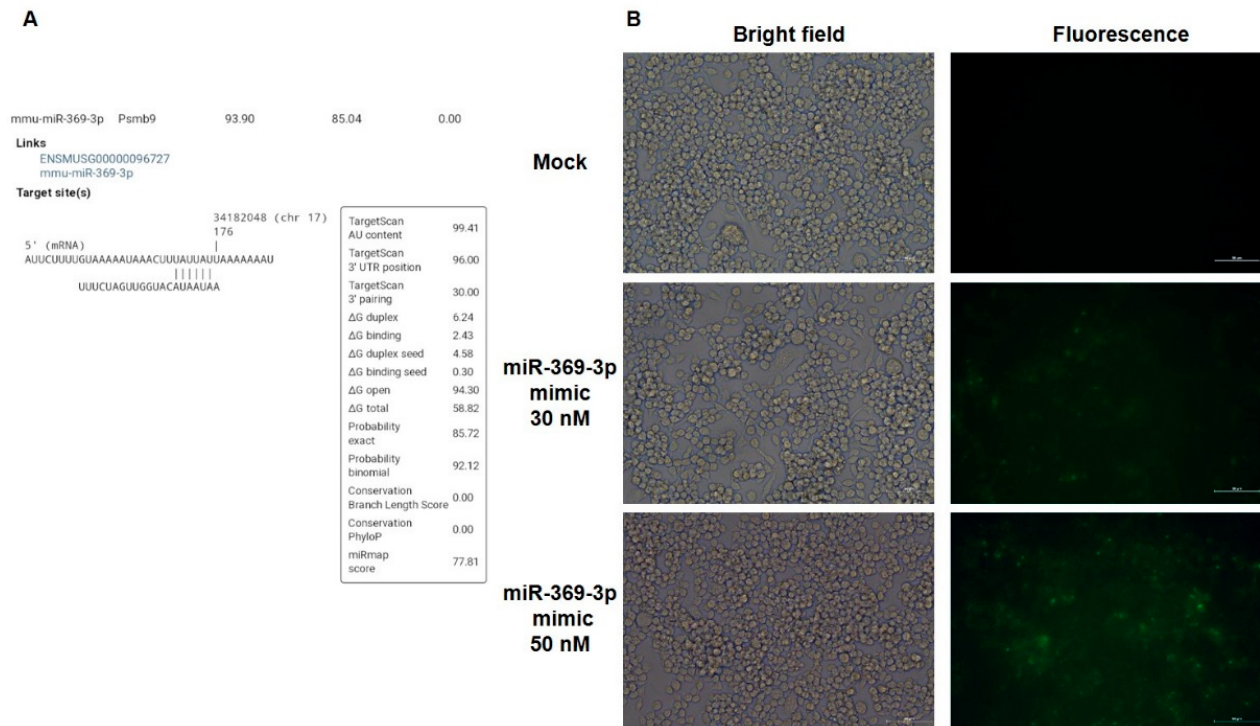
Figure 1. miR-369-3p targets Psmb9, binding a specific sequence in 3 ′ UTR mRNA. ( A ) Sequence alignment of the miR-369-3p base pairing sites in 3 ′ UTR of Psmb9 mRNA. ( B ) Transfection efficiency of RAW 264.7 mouse macrophages. RAW 264.7 cells were transfected with FAM-labeled miR-369-3p mimic at concentrations of 30nM and 50nM. Representative images of RAW 264.7 transfected with FAM-labeled miR-369-3p mimic. Bright field (left) and fluorescence (right) images for the mock condition and transfected conditions were acquired by fluorescence microscopy. Original magnification, ×20. Scale bar presents 50 μ m.